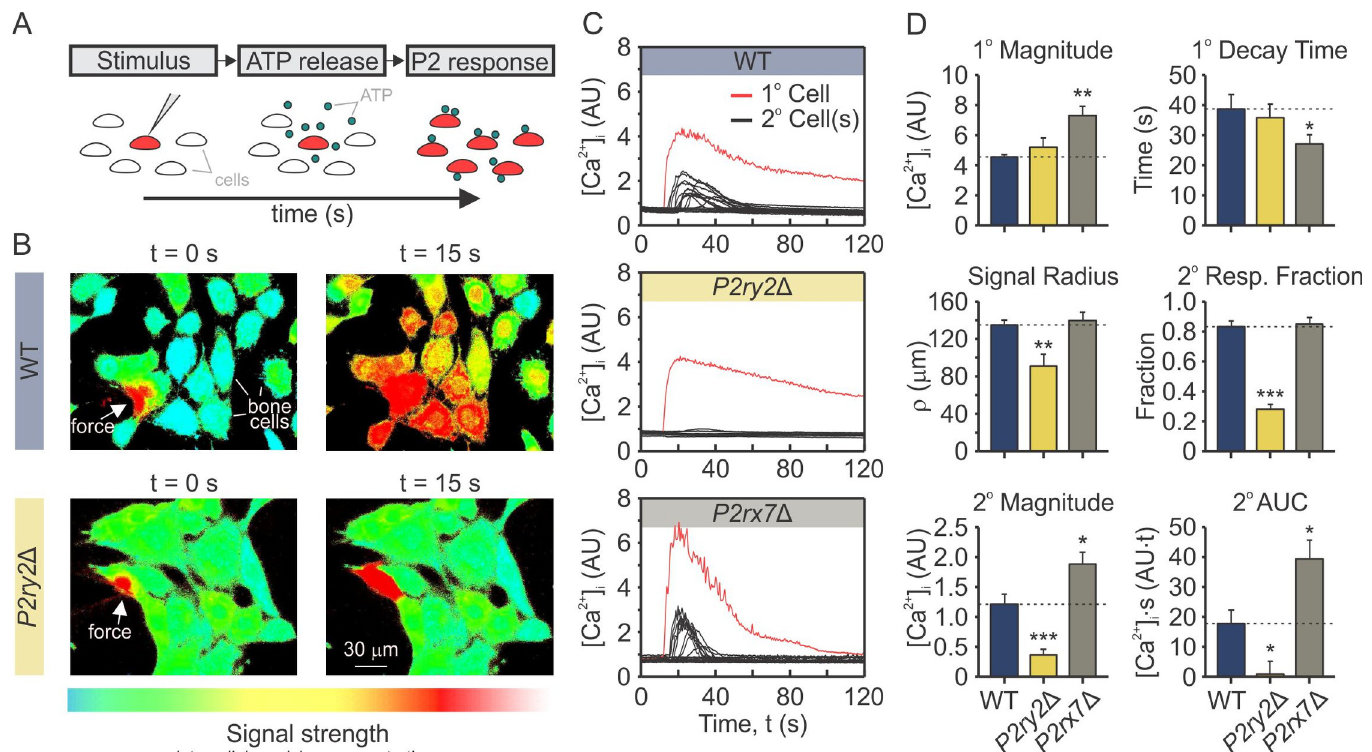
Fig 8. P2Y2R and P2X7R contribution to mechanically stimulated signals in bone cells. (A) Fura2-loaded C2-OB cells were plated on a glass-bottom dish and individual cell ( primary; 1° ) was mechanically stimulated with a glass-micropipette inducing ATP release into the extracellular space, which subsequently stimulated P2 responses in neighbouring cells ( secondary; 2° ). (B) Representative images of [Ca 2+ ] i (pseudocolor of 340/380 ratio) in C2-OB parental ( top ) and P2ry2 Δ ( bottom ) cultures, in which a single cell was mechanically stimulated at t = 0 s (white arrows). The snapshot at 15 s demonstrate secondary responses in neighboring cells. Red traces : primary responses; Black traces : secondary responses. ( C ) Time-series recordings in WT ( top panel ), P2ry2 Δ ( middle panel ), and P2rx7 Δ ( lower panel ) cells. (D) Quantification of primary and secondary [Ca 2+ ] i response parameters, including signaling radius, fractions of responding cells, response magnitudes and areas under the curves in WT ( blue ), P2ry2 Δ ( yellow ), and P2rx7 Δ ( grey ) cells. Data are means ± SEM, � p < 0.05, �� p < 0.01 and ��� p < 0.001 indicate comparisons between WT and P2ry2 Δ or P2rx7 Δ cells assessed by ANOVA and Bonferroni-corrected t-test. AU: arbitrary